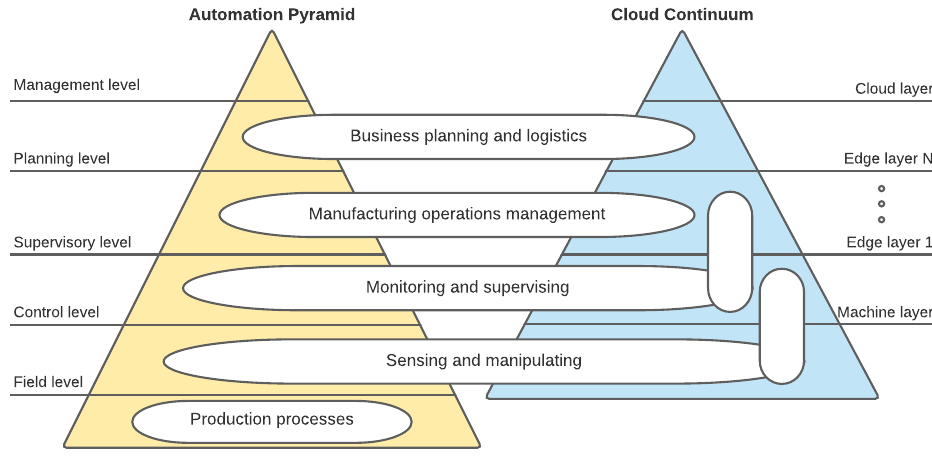
Figure 1. Automation pyramid remapped on Cloud continuum